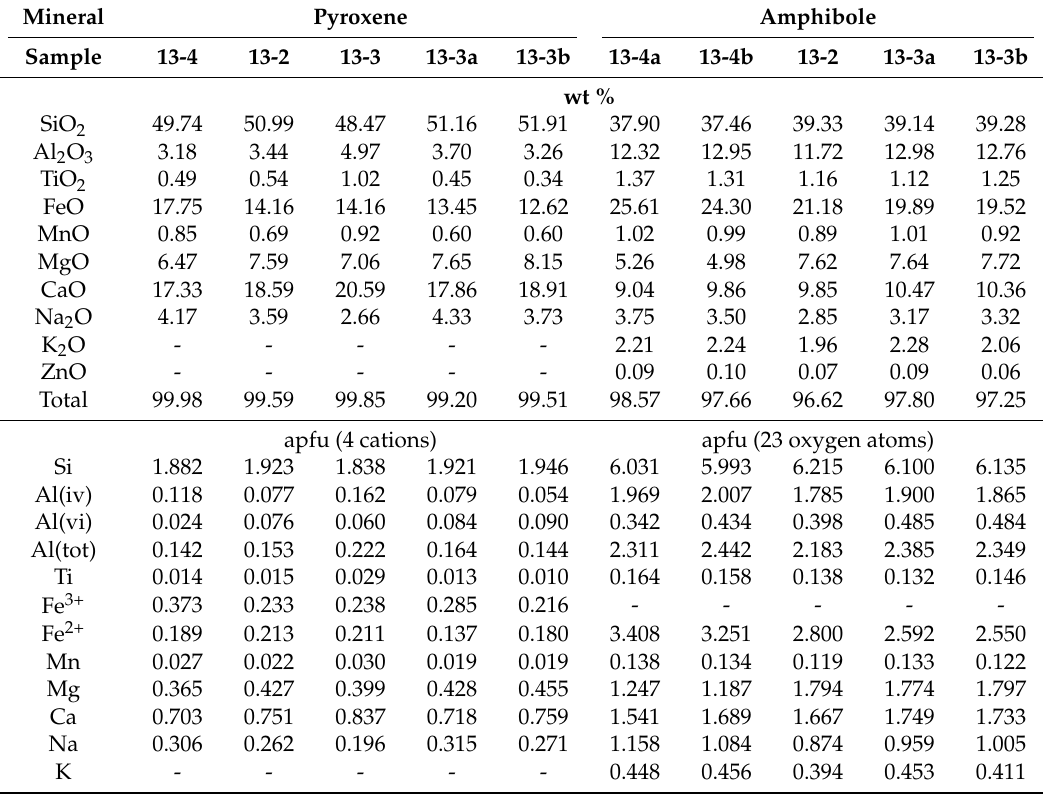
Table 2. Chemical analyses of pyroxene and amphibole from Breivikbotn carbonatite. Mineral